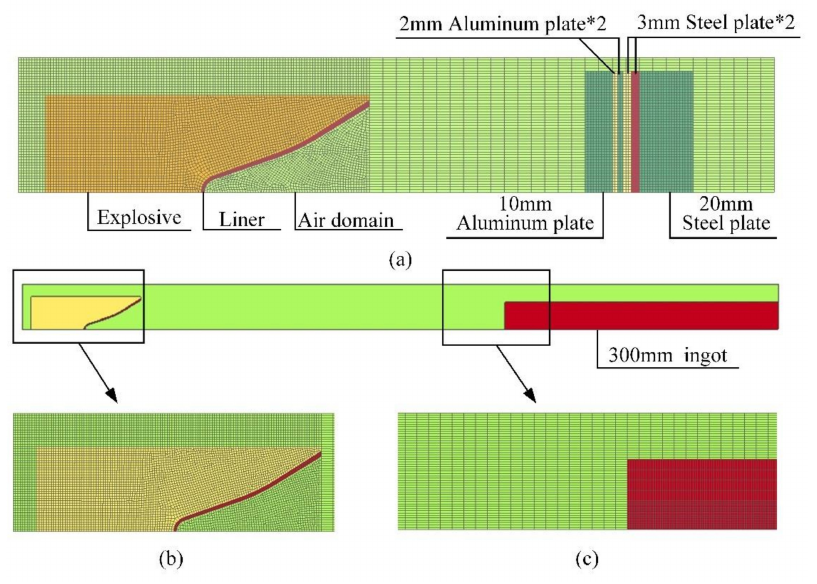
Figure 4. Finite element model. ( a ) Finite element model of the warhead penetrating the control cabin and target plate, with 177,536 grids; ( b ) finite element model of the warhead penetrating into a 300 mm Q235 ingot, with 337,420 grids; ( c ) Grid condition at the junction of ingot and air